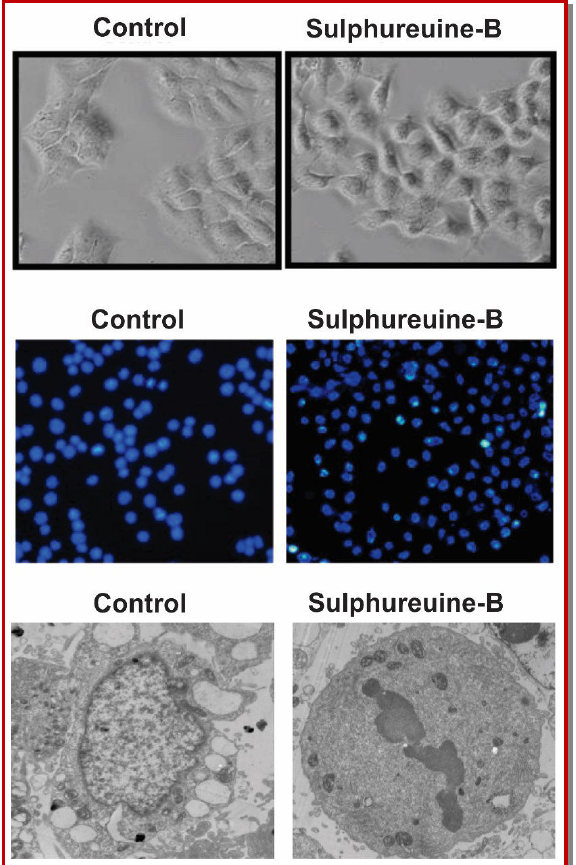
Figure 3: U-87MG cells treated with 20 µM of sulphureuine B using phase contrast microscopy (upper row); Hoechst staining results by the treatment of U-87MG cells with 20 µM of sulphureuine B (middle row); TEM ultrastructure results upon treating cells alone or with 20 µM sulphu- reuine B ((lower